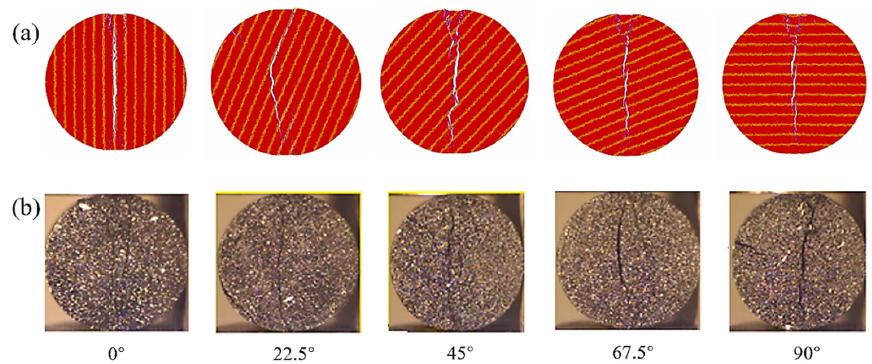
Figure 27. Comparison of numerical simulation and experimental results. ( a ) Failure models of coal specimen with different bedding angles. ( b ) SHPB test.